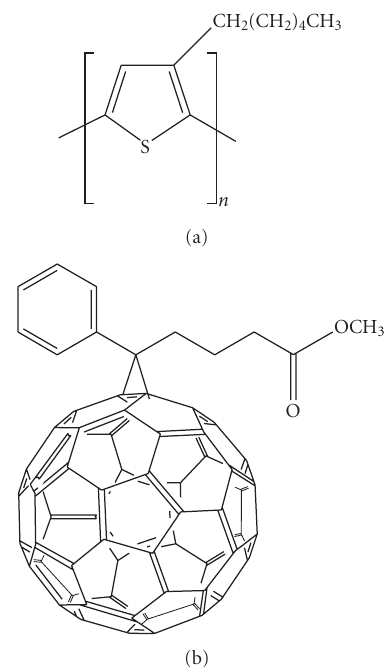
Figure 1: Chemical formulas of (a) P3HT and (b) PCBM.